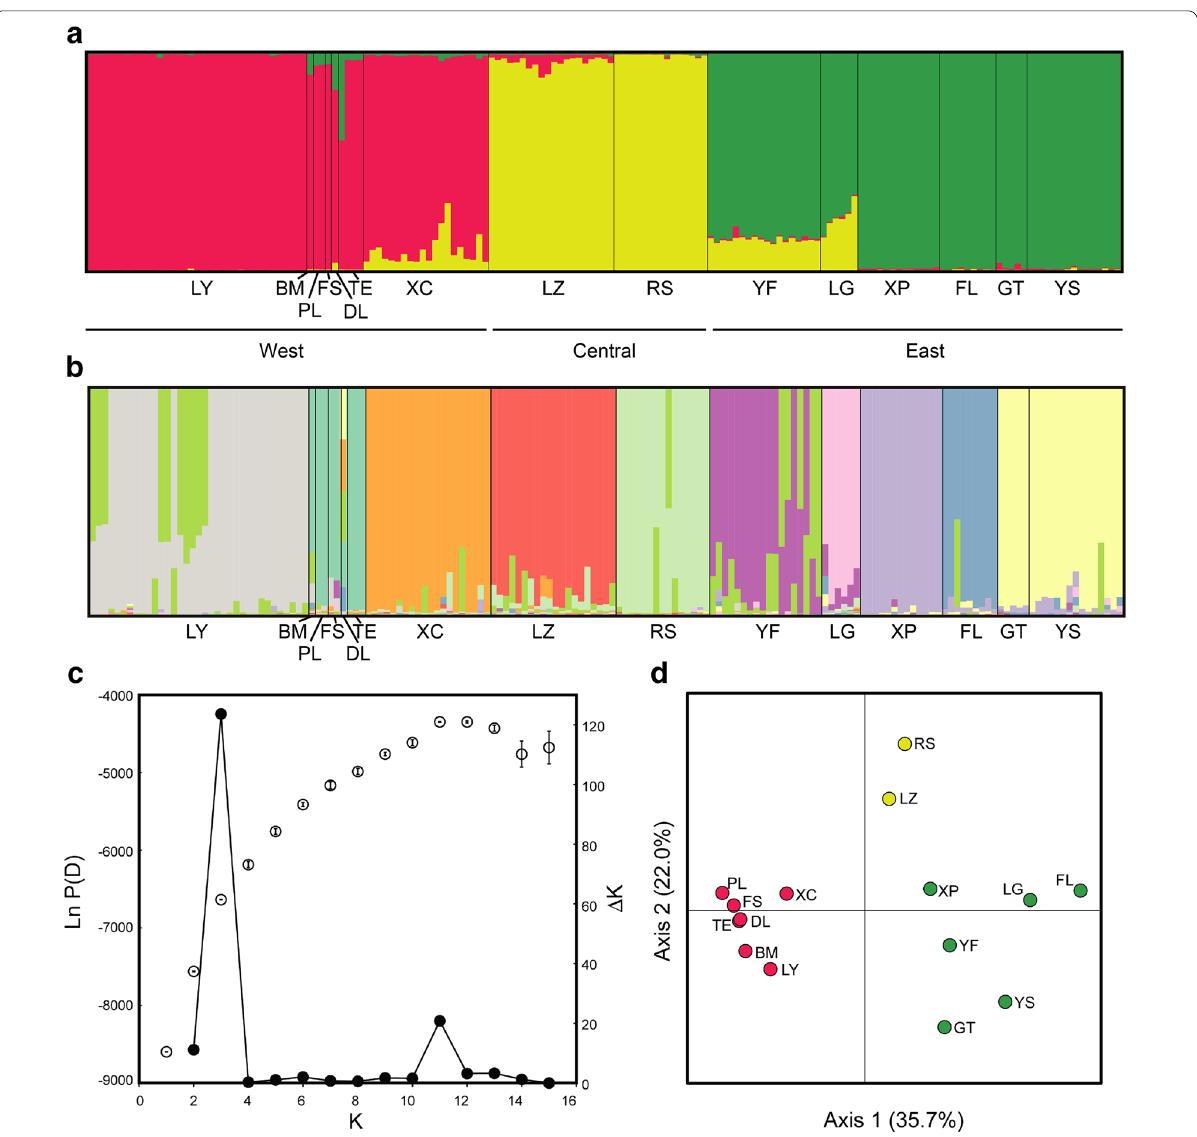
Fig. 3 The results of STRU CTU RE & PCoA. a STRC TUR E bar plot representing K populations of Begonia luzhaiensis based on genetic variation of 16 EST‑SSR loci. Each vertical bar represents an individual plant is represented by a single vertical line grouped by populations. b STRC TUR E bar plot representing K analysis is based on EST‑SSR loci using